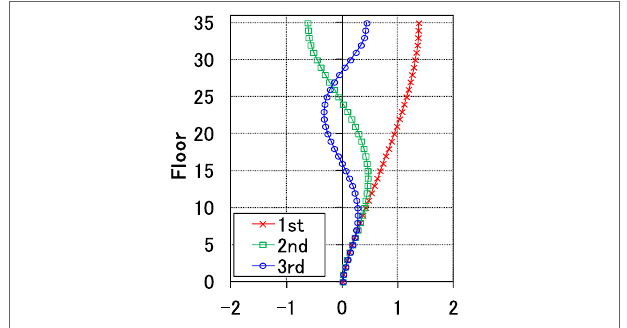
FigUre 6 | Participation function (N–S direction) of the model using an initial property sway-rocking spring.